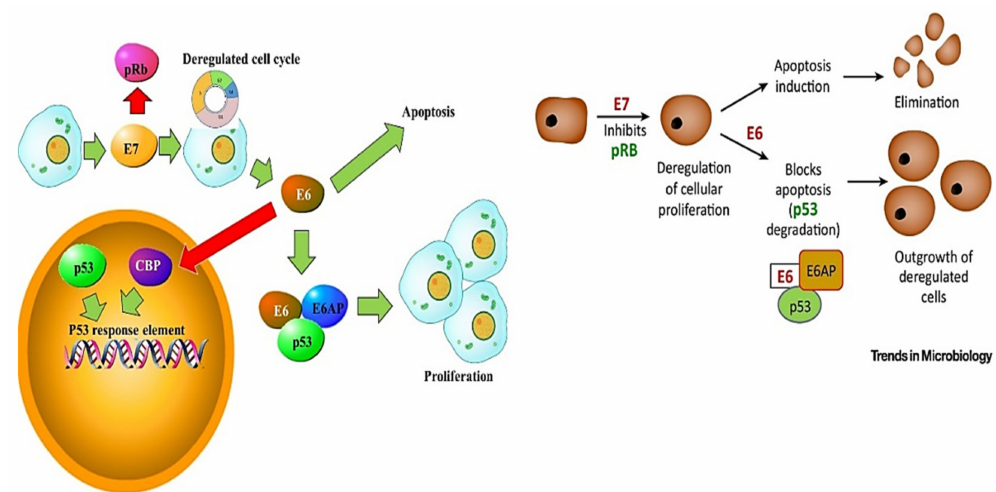
Figure 6. DDR and apoptosis signalling involving E6 and E7. E6 targets p53 by forming a ternary complex with E6-associated protein (E6AP), inducing the degradation of p53. Additionally, the E6 protein binds the transcriptional co-activator cAMP response element binding protein (CREB) binding protein/p300 (CBP/p300), downregulating the ability of CBP/p300 to activate p53 responsive elements. Furthermore, E7 prevents cell cycle inhibition. E7 also binds and inhibits the retinoblastoma (pRB) protein family, interfering with the pRB/E2F interaction. Normally, E2F induces the transcription of S phase genes such as cyclins A and